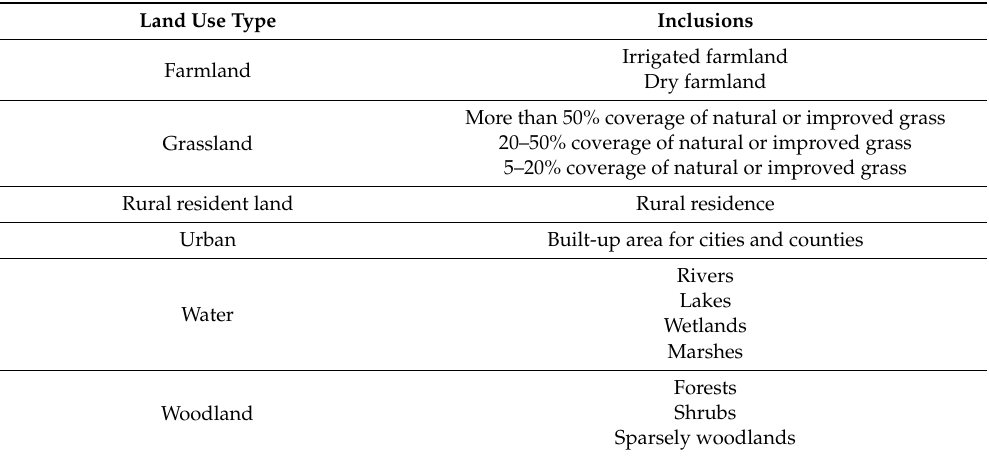
Table 2. Detailed inclusions of land use types in the study.